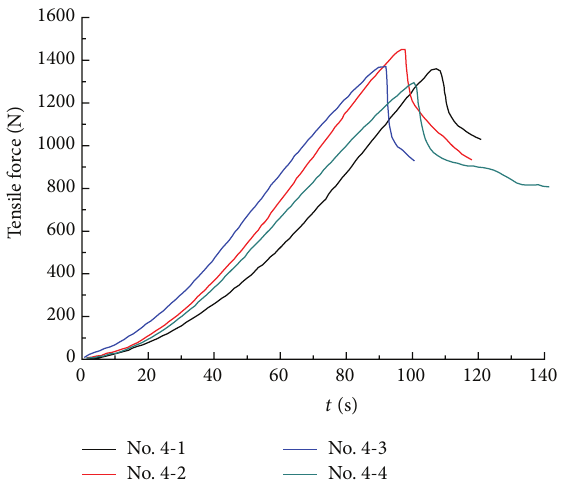
Figure 12: Load-time curve: Brazilian disk specimen used for the determination of rock tensile